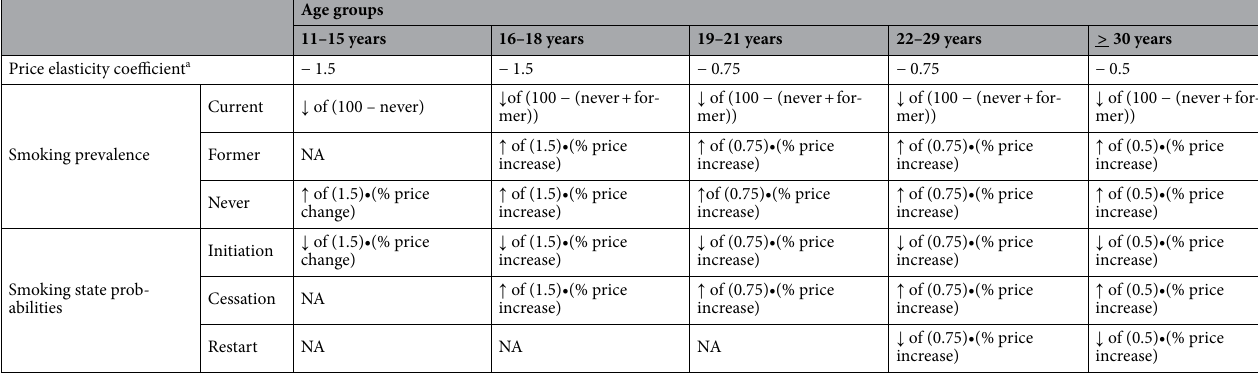
Table 4. Predicted changes in smoking prevalence and smoking state probabilities attributable to a one-time tobacco price increase. NA = no change possible because of constraints placed on age ranges (e.g. smoking cessation only possible ≥ 16 years of age). a Defined as the percentage change in tobacco per 1% increase in tobacco